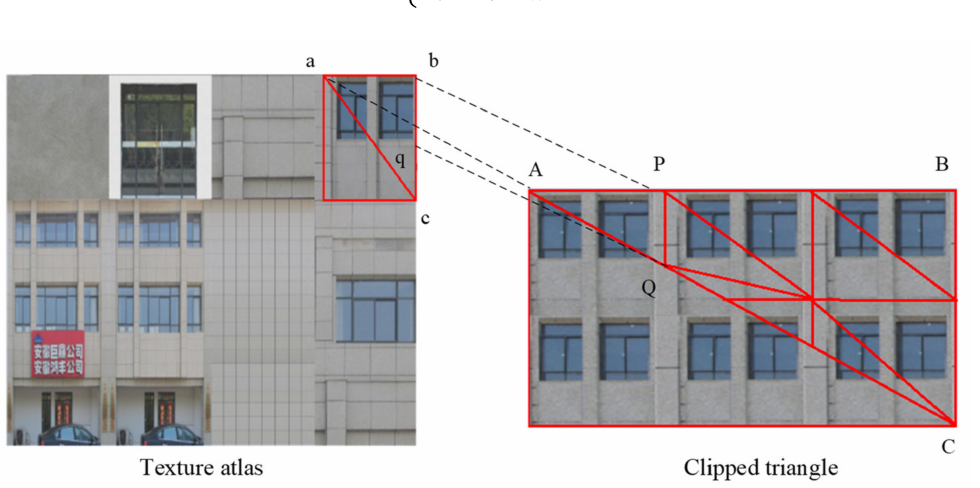
Figure 7. Clipped triangle